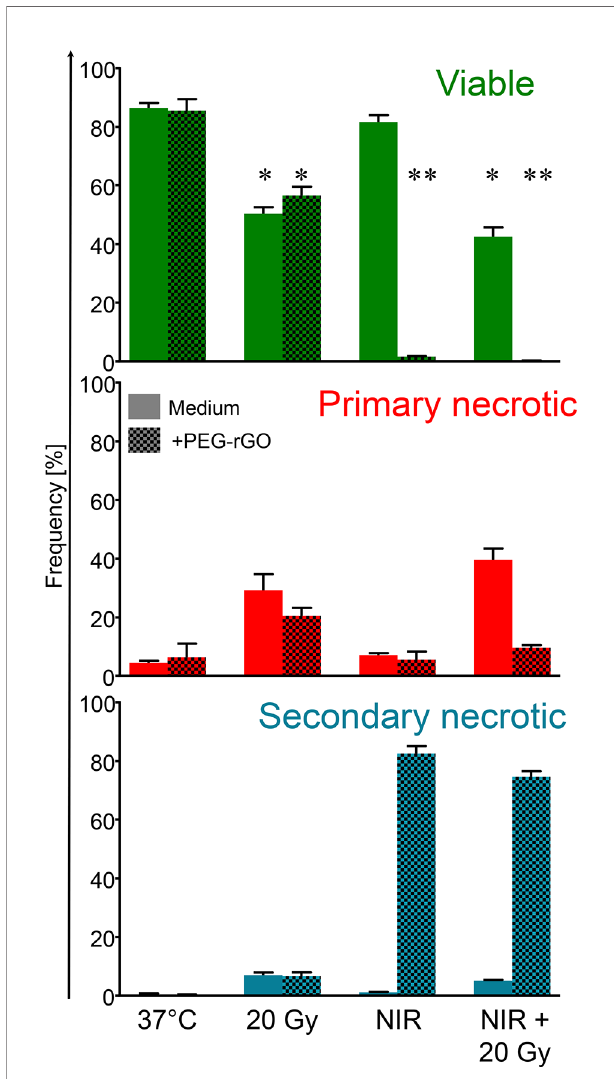
FIGURE 1 | Frequencies of subpopulations of dead and dying cells. B16F10 melanoma cells exposed to gamma irradiation (20 Gy), graphene induced hyperthermia (GITH) or the combination were classi fi ed by fl ow cytometry employing multiparametric cell staining after 24 hours. Viable cells, green, negative for PI and AxA5. Primary necrotic cells, red, positive for PI and AxA5 with high DNA content (Hoechst). Secondary necrotic cells, blue, positive for PI and AxA5 with low DNA content (Hoechst). NIR, near infrared irradiation; Gy, Gray; PI, propidium iodide; AxA5, annexin A5. *p < 0.05; **p <